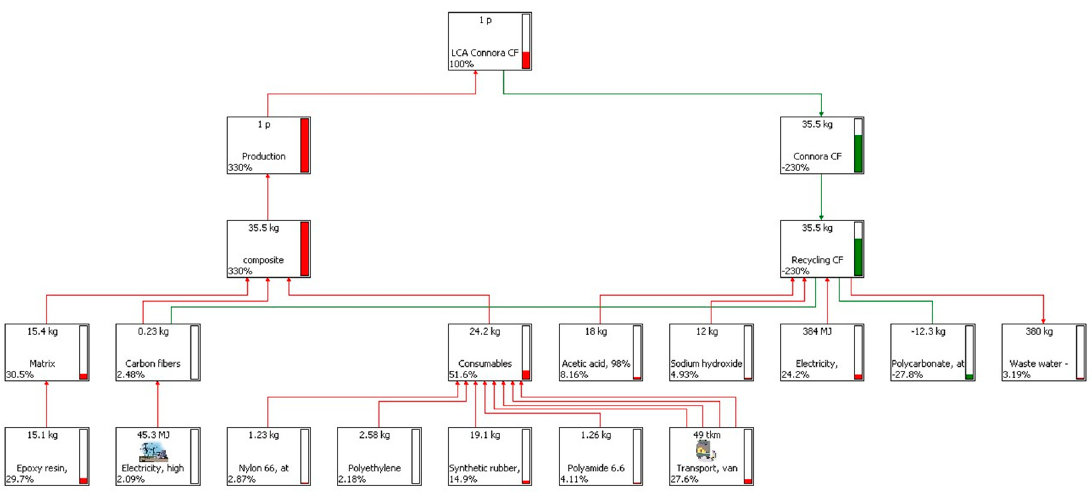
Figure 7. LCA diagram of the production and recycling of the CF-laminate. Scenario (a): the CFs are recovered and reused as they are.